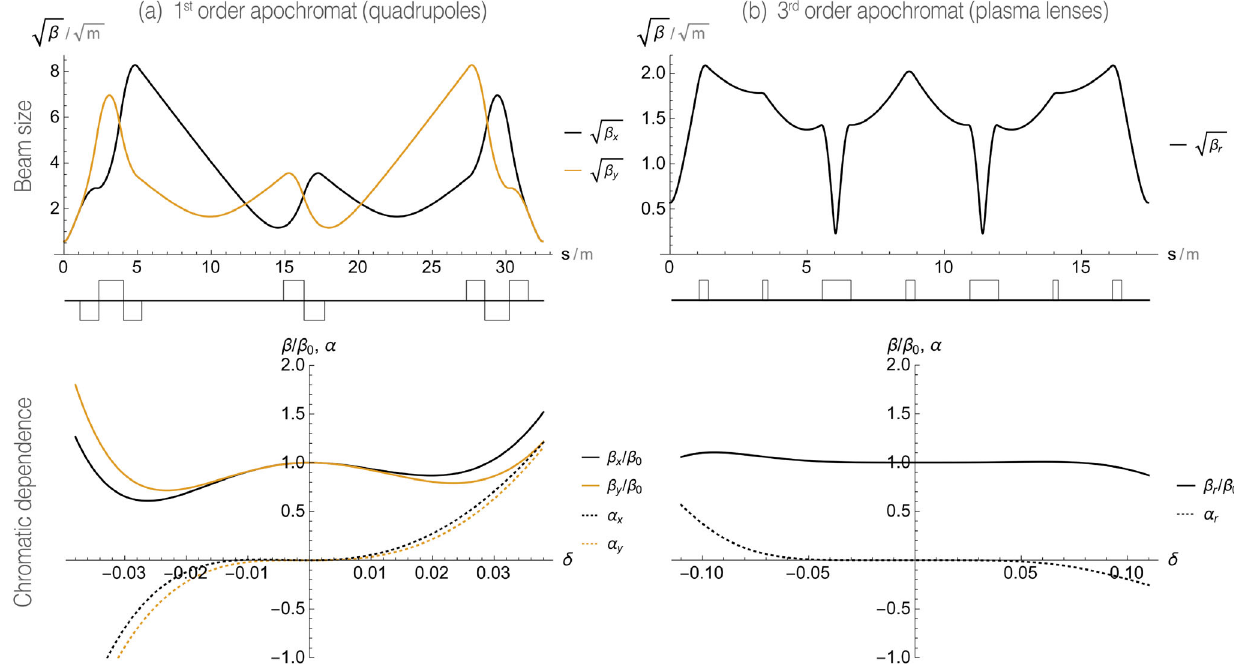
ffiffiffi p β (proportional to rms beam